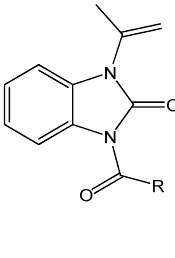
Figure 1. N -acylated